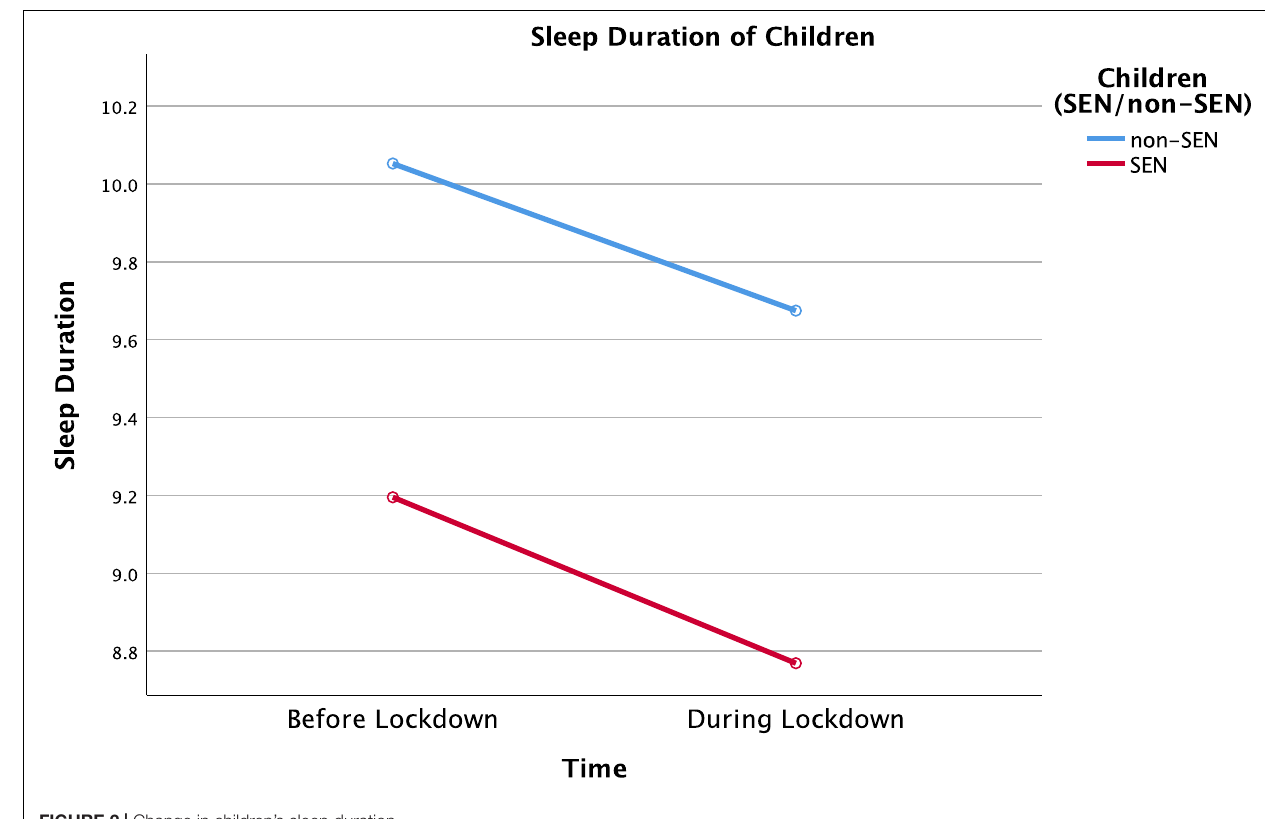
FIGURE 2 | Change in children’s sleep